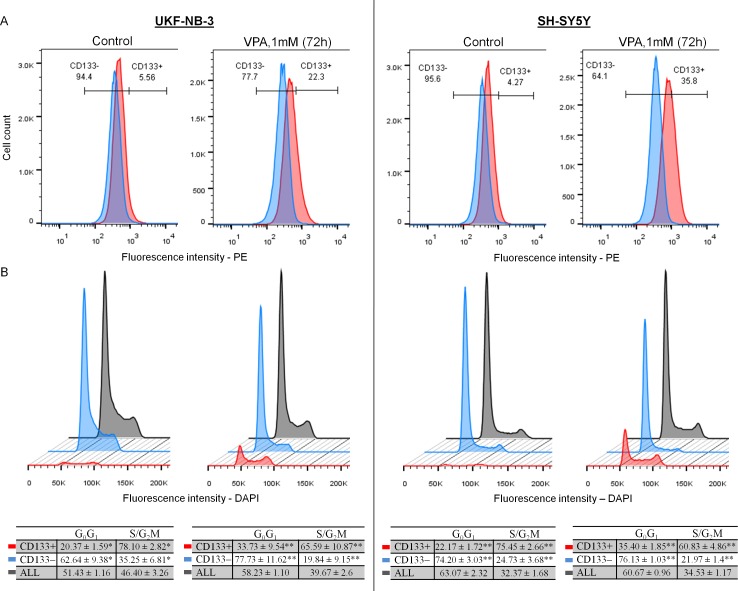
Cytometric assessment of CD133− and CD133+ and their cell cycle in control cells and after cultivation with 1mM VPA for 72 hrs in UKF-NB-3 and SH-SY5Y.(A) VPA Increased the number of CD133+ cells in both cell lines. Blue—isotype control (IgG2b-PE); red—CD133 expression detected by 293C3-PE (CD133/2) antibodies. (B) CD133+ cells were mainly located in the S and G2/M phases, while CD133− were mainly present in the G0/G1 phases.